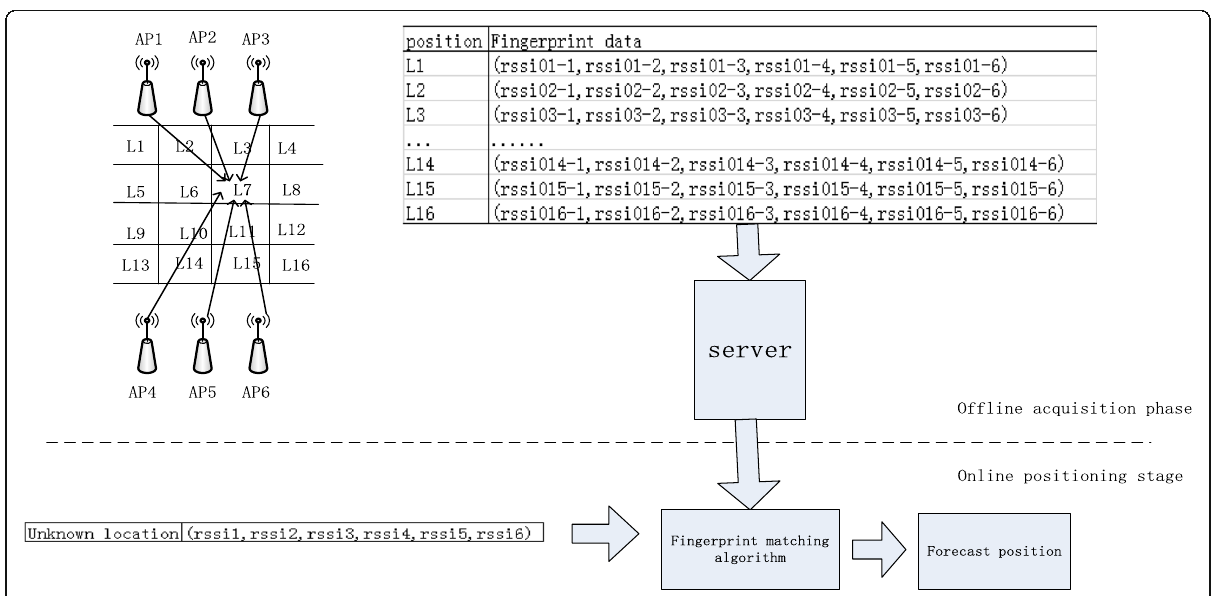
Fig. 3 The schematic diagram of position fingerprint locating algorithm